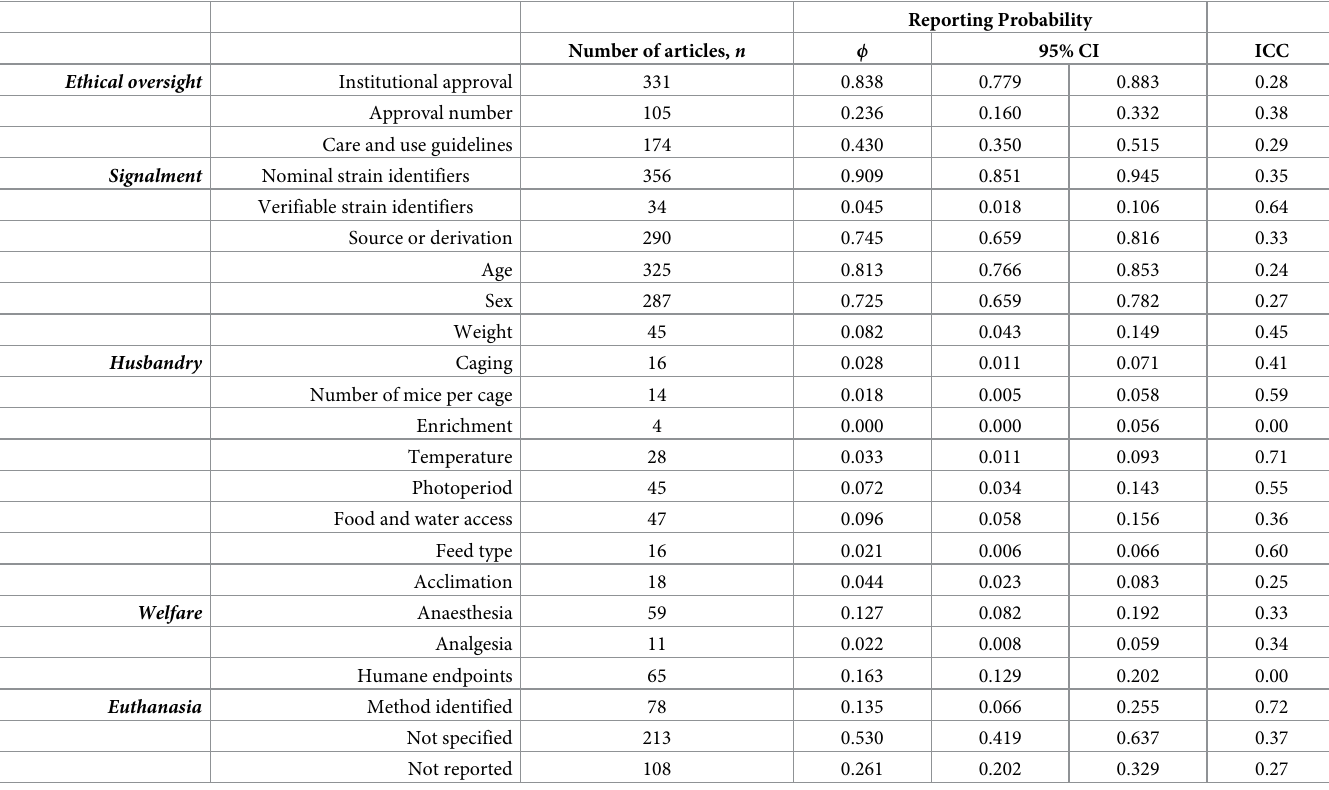
Table 1. Summary of reporting probability ϕ (proportion of articles reporting a given item, corrected for journal membership) with 95% confidence intervals, and intraclass correlation (ICC ) , estimated from two-level hierarchical models of articles nested within